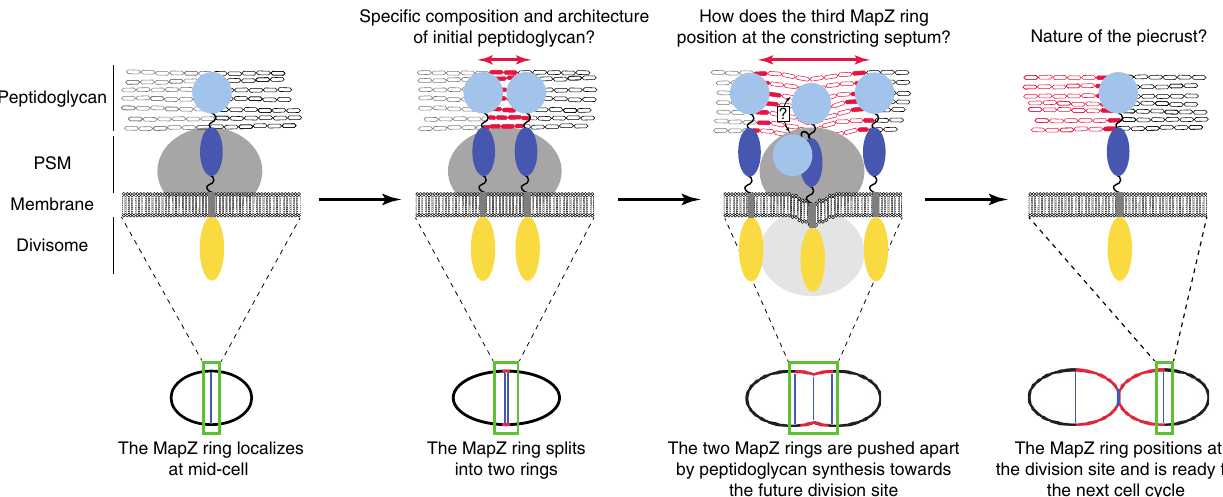
Figure 7 | Model of MapZ positioning at the division site. The upper part of the figure shows magnifications of the different cell division stages of the pneumococcus that are presented in the lower part. MapZ localizes at the interface between the two cell halves of newborn cells. Black and grey ovals distinguish the cell wall of each half-cell. The cytoplasmic domain of MapZ, MapZ extra1 and MapZ extra2 are represented by yellow, dark and light blue ovals, respectively. Initial peptidoglycan synthesis (red ovals) is recognized by MapZ extra2 that is shifted towards the cell equator of the two daughter cells. Insertion of peptidoglycan allowing cell elongation and whose composition might be different from that of initial peptidoglycan is shown as open red ovals. The cytoplasmic part of the divisome and the peptidoglycan synthesis machinery (PSM) are shown in light and dark grey, respectively. For visual clarity, the divisome is not indicated in the first two stages of the cell division process. The question mark indicates the possible structural rearrangement of MapZ extra when localizing as a third ring at the constricting